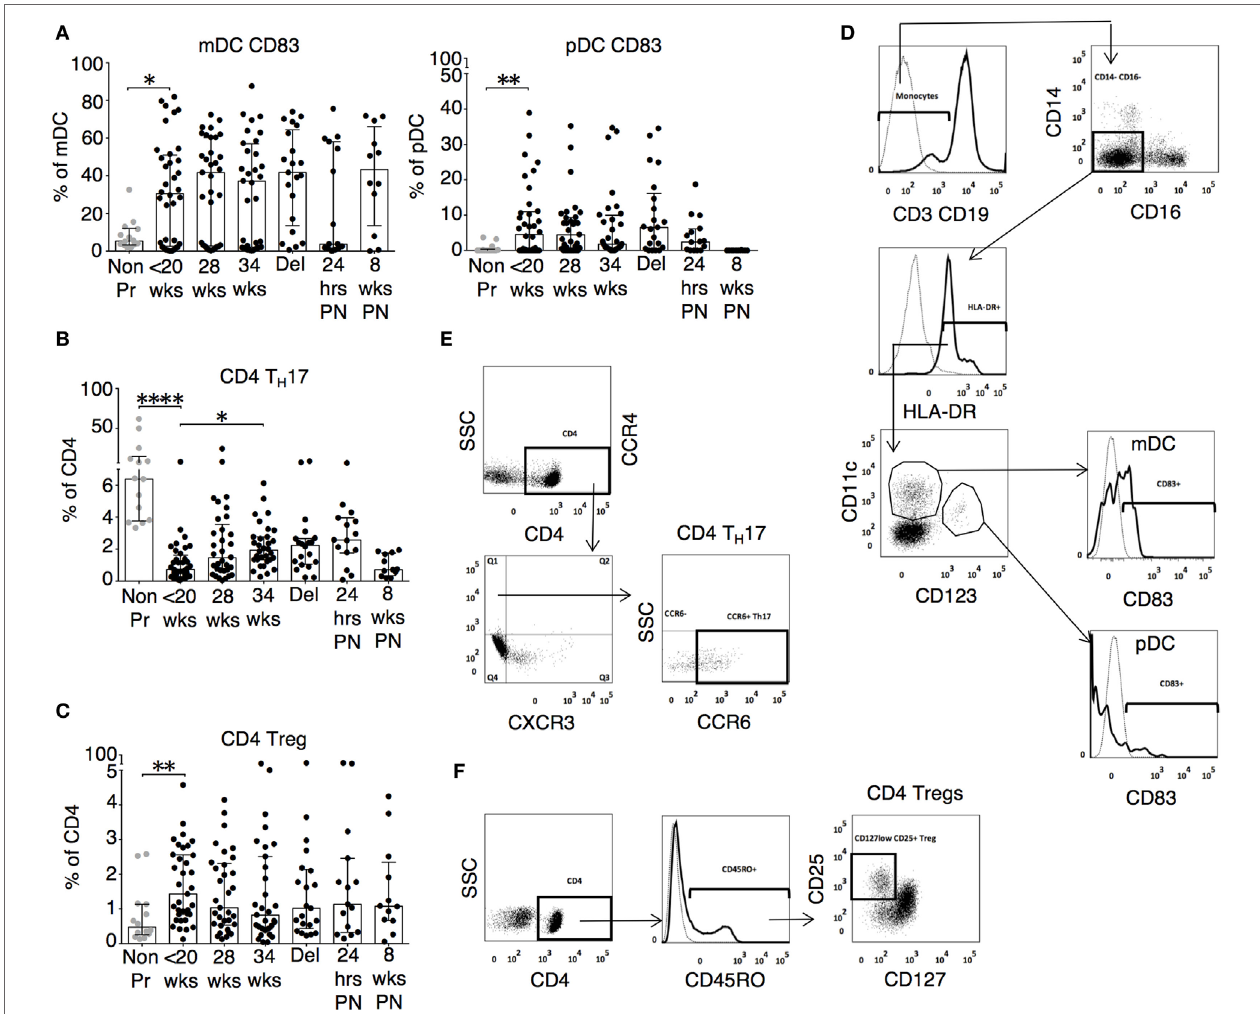
FigUre 3 | Inflammatory, activated, and cytotoxic leukocyte subsets show gestational variation in pregnancy. (a) Proportions of activated mDC (CD3 − CD19 − CD14 − CD16 − HLA-DR + CD11c + CD123 − CD83 + ) and pDC (CD3 − CD19 − CD14 − CD16 − HLA-DR + CD11c + CD123 + CD83 + ) during pregnancy and compared with gestation matched controls. (B) Longitudinal analysis of T H 17 cells (CCR4 + CXCR3 − CCR6 + ) and (c) regulatory T cell (Tregs) with phenotype CD4 + CD45RO + CD25 + CD127 lo in pregnancy and compared with gestation matched controls. Gestation at sampling is indicated in pregnancy ( ⚫ ): < 20 + 0 weeks ( N = 42 ), 28 weeks ( N = 35 ), 34 weeks ( N = 33 ), at delivery ( N = 24 ), 24 h post-delivery ( N = 22 ), 6–8 weeks postnatal ( N = 13 ). Non-pregnant controls are depicted as ⚫ ( N = 14 ). P values are two tailed and significance is defined as * P < 0.05 and ** P < 0.01 **** P < 0.0001. Non-pregnant and baseline pregnant data analyzed by Mann–Whitney U test. Longitudinal data analyzed by generalized linear mixed effects model with gamma log-link and pairwise multiple comparisons of estimated marginal means with sequential Bonferroni correction. Representative flow cytometry plots of (D) dendritic cell subtypes mDC and pDC, (e) T H 17 CD4 T cells, and (F) CD4 + Tregs and, and their respective gating